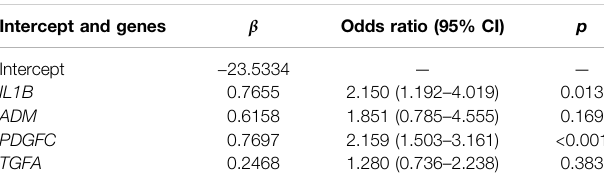
TABLE 2 | Diagnostic markers for